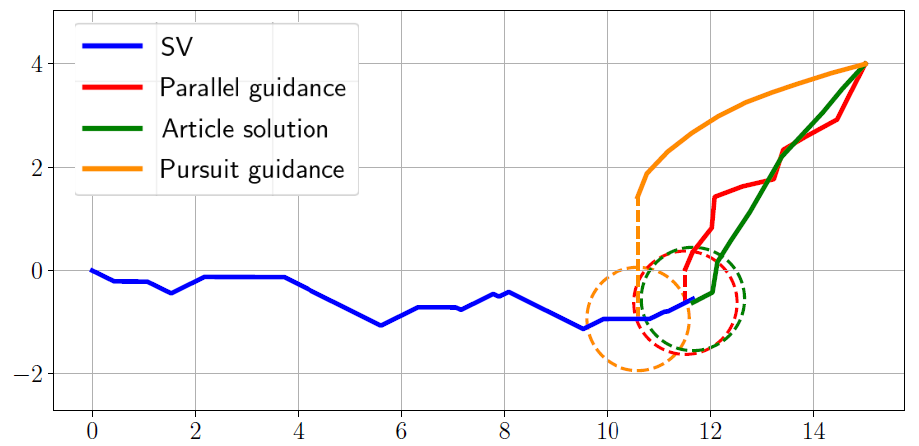
Figure 9. Comparison of different guidance